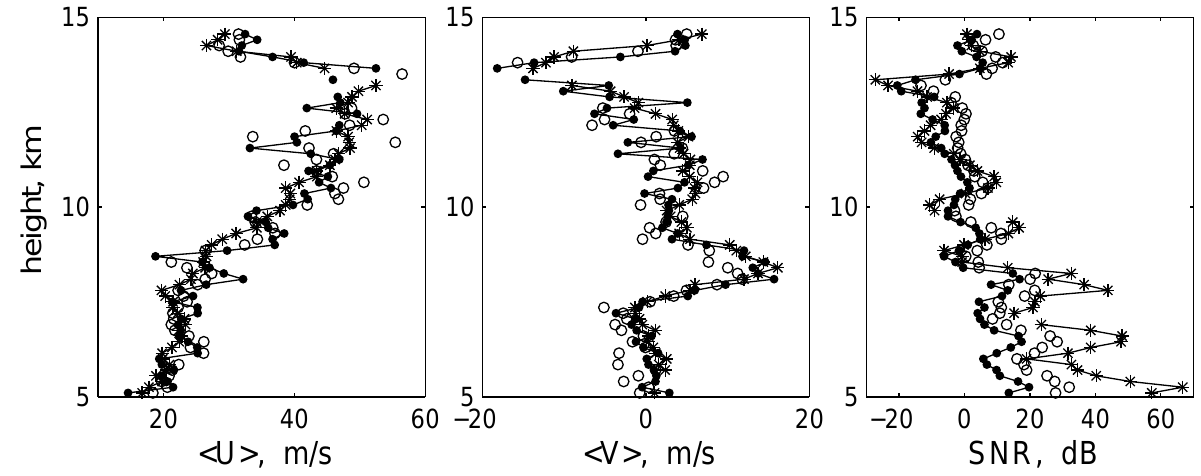
D E D E U V and northerly mean horizontal wind speed components and SNR above the MUR on